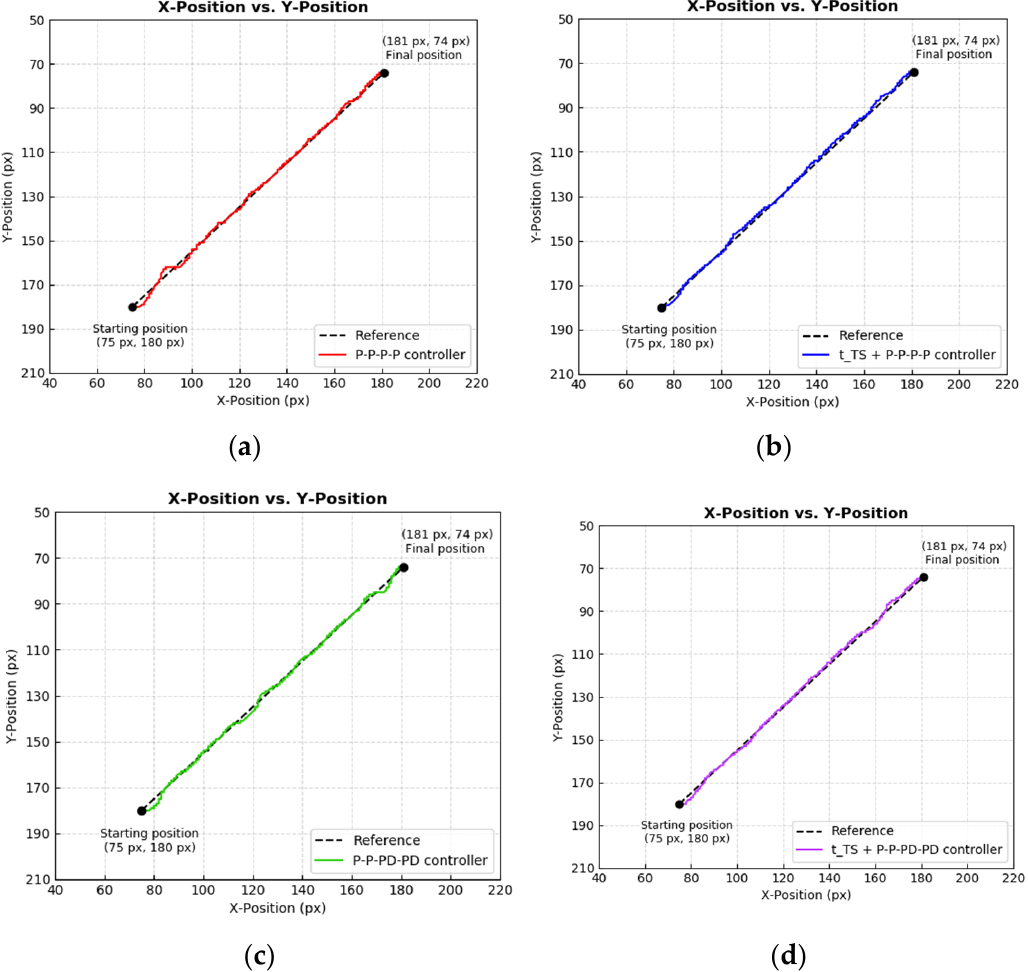
Figure 17. Diagonal-shaped trajectory tracking performance by ( a ) P–P–P–P controller, ( b ) t TS + P–P–P–P controller, ( c ) P–P–PD–PD controller, and ( d ) t TS + P–P–PD–PD controller on Cartesian plane.